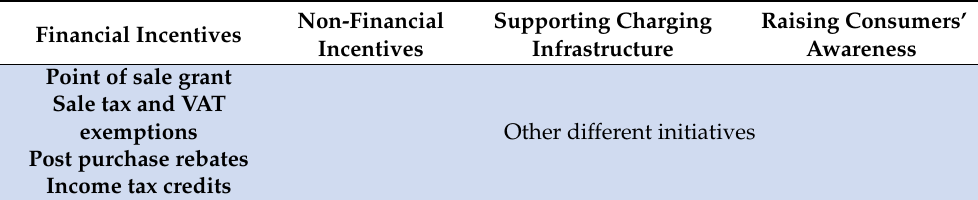
Table 2. Policy mechanisms and